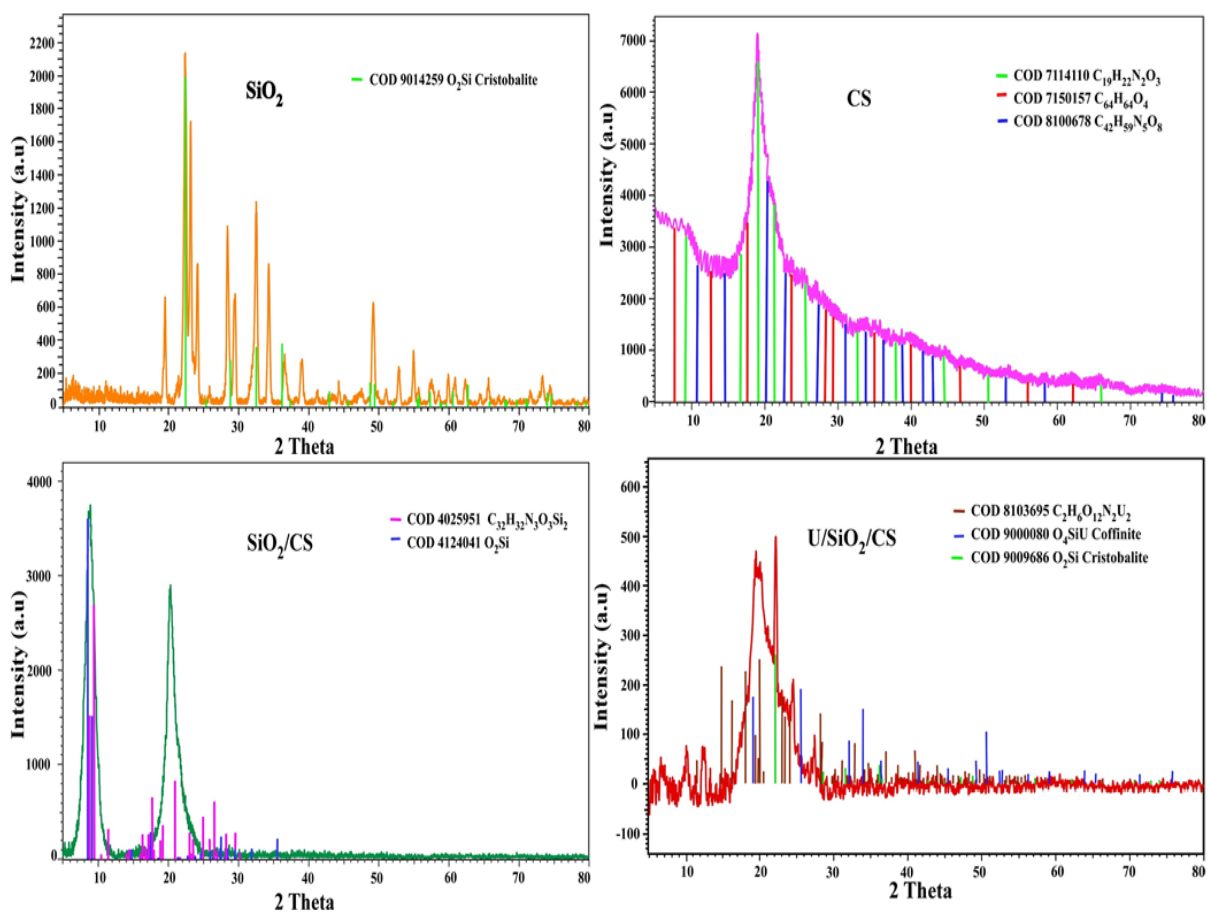
Figure 1. SiO 2 , CS, SiO 2 /CS, and U/SiO 2 /CS XRD patterns.